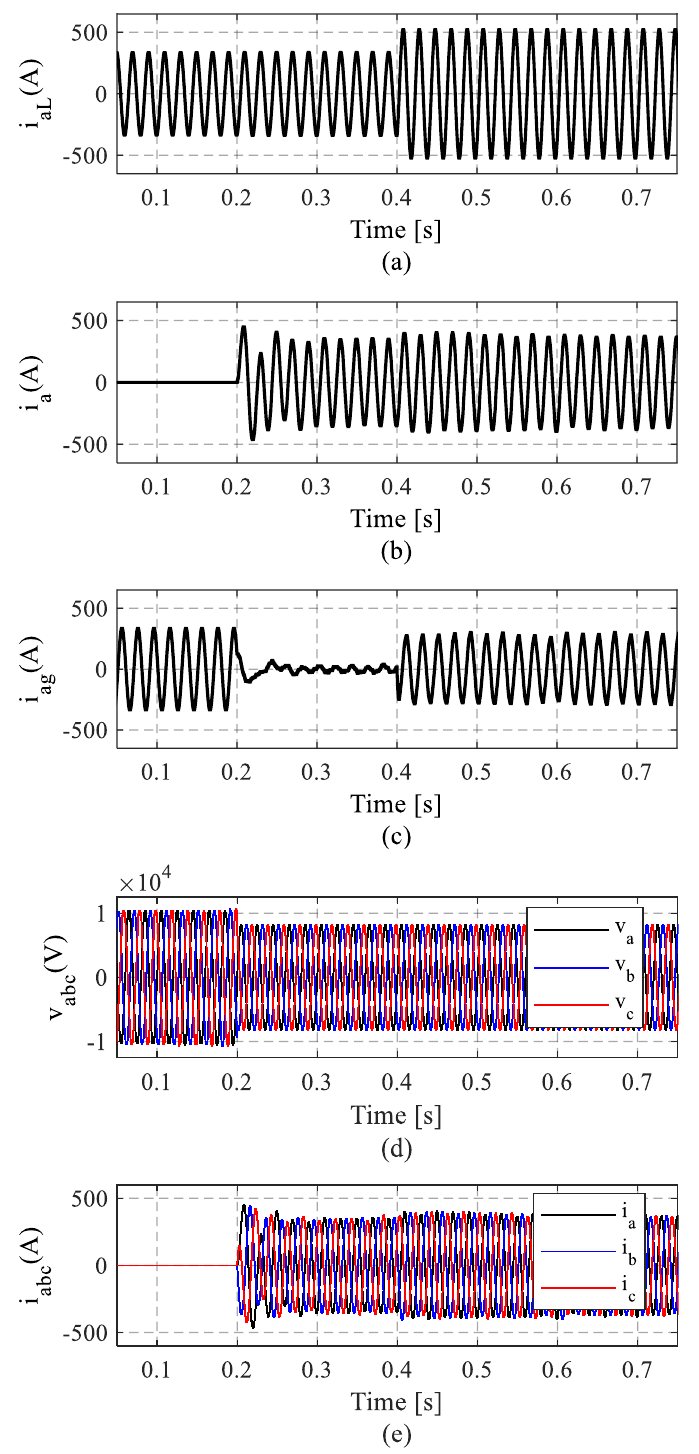
Figure 6. Simulated waveforms of the MMC-based STATCOM structure: ( a ) Phase-a waveform of load current; ( b ) Phase-a waveform of converter output current; ( c ) Phase-a waveform of grid current; ( d ) Output voltages of MMC; and ( e ) Output currents of MMC.